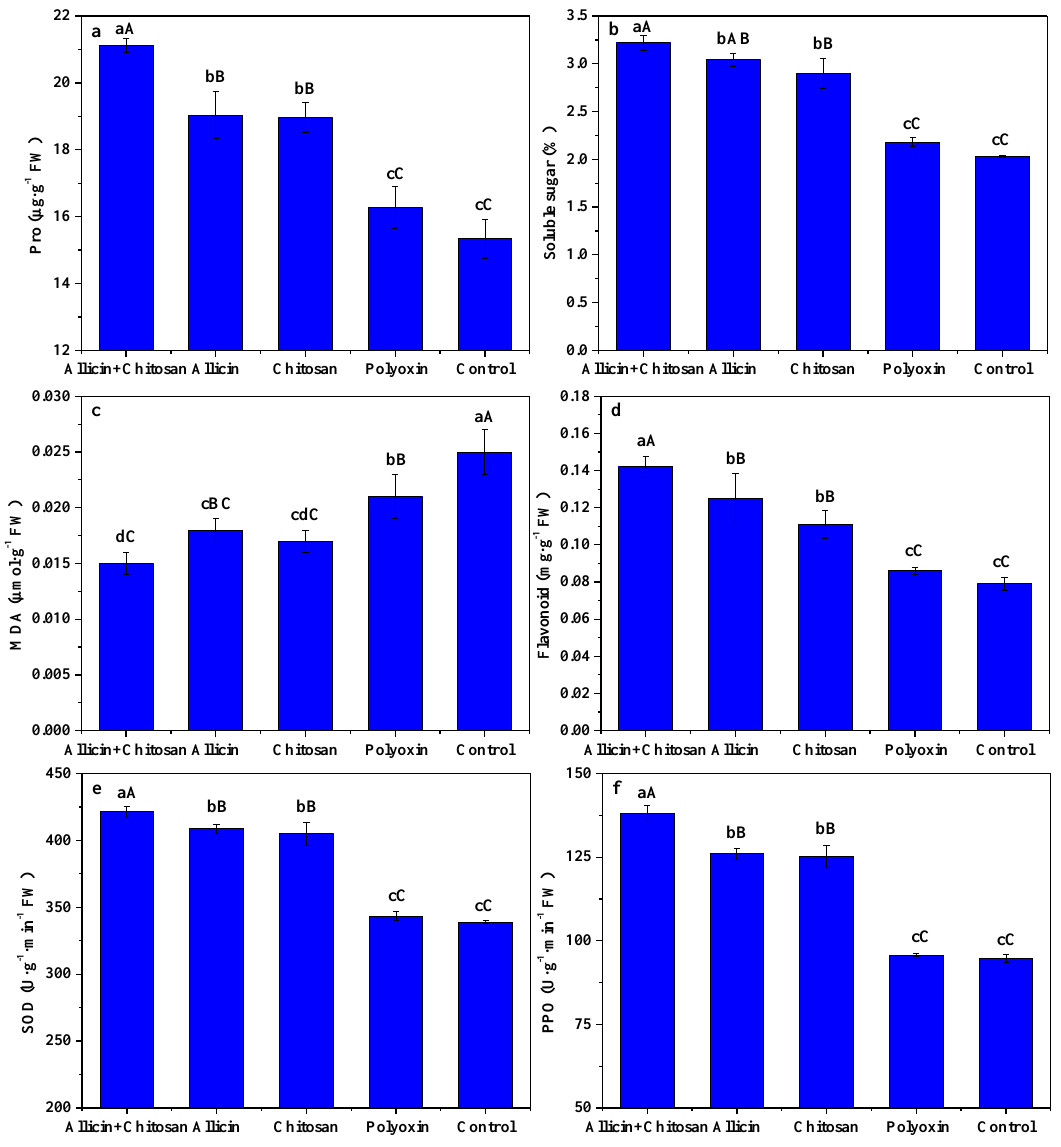
Figure 1. The effects of allicin and chitosan on the Pro ( a ), soluble sugar ( b ), malonaldehyde ( c ), flavonoid ( d ), SOD activity ( e ), and PPO activity ( f ) of leaves in R. roxburghii . Values and error bars indicate the mean and SD of three replicates, respectively. Different small letters indicate significant differences at 5% level ( p < 0.05), and different capital letters indicate significant differences at 1% level ( p < 0.01).